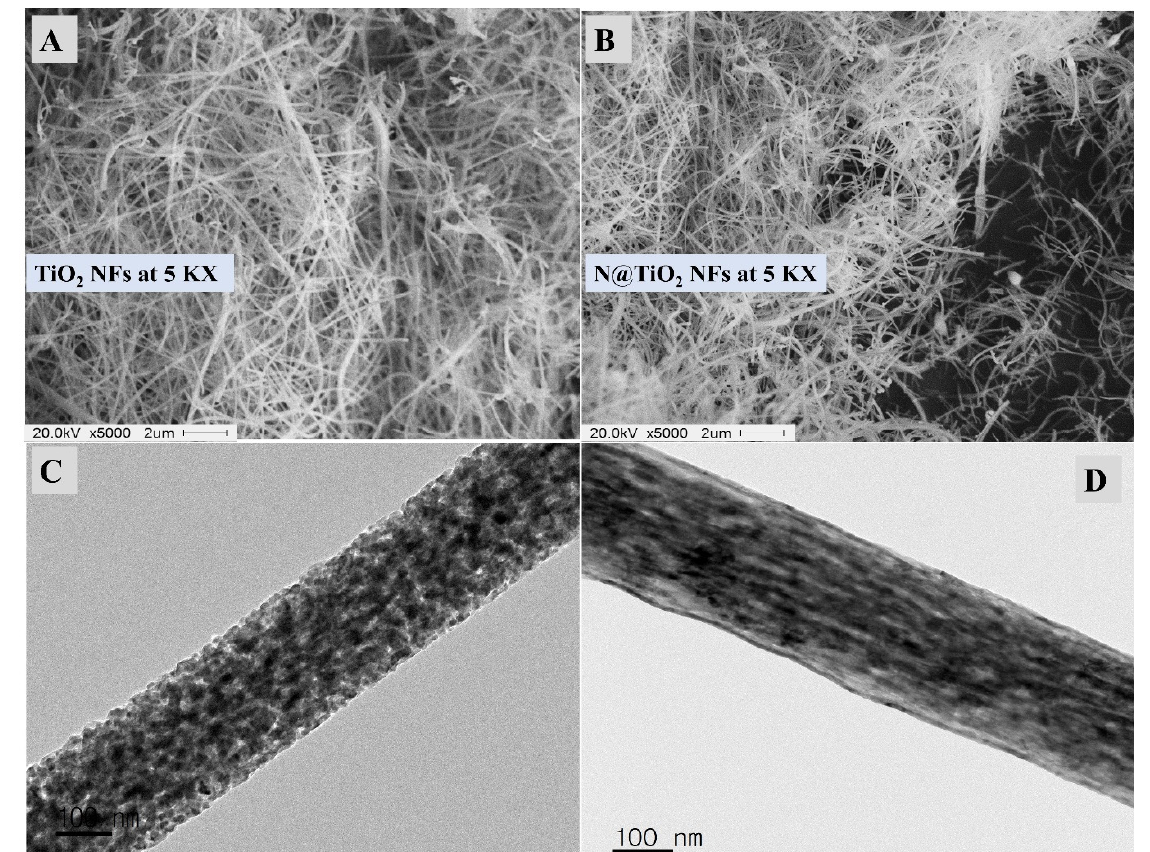
Figure 2. ( A ) SEM image of the prepared Titania; ( B ) SEM image of N-Titania; ( C ) TEM image of the prepared Titania; ( D ) TEM image of the prepared N-Titania.